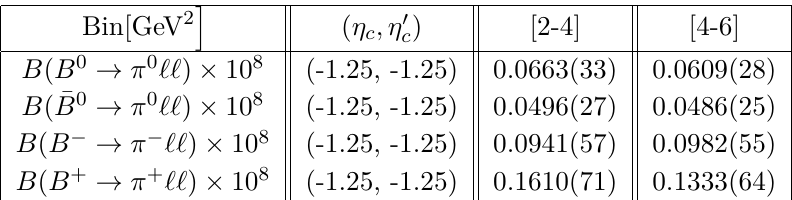
Table 48 . Predictions of branching fractions for B ± → π ± ‘‘ decays on rescaling the charm vacuum polarisation.